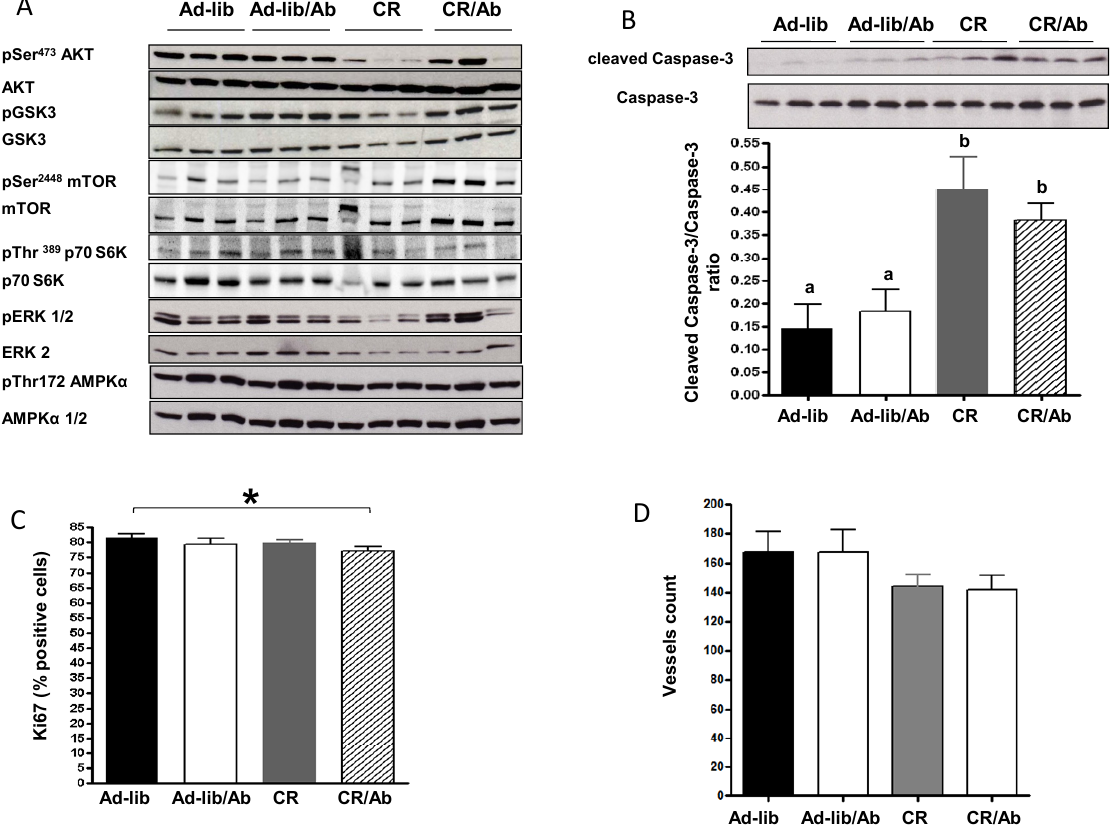
Figure 5. Effect of the different therapies on Akt pathway activation, apoptosis and proliferation. ( A ) Activation of the Akt pathway was assessed by western blotting on xenograft tissue lysate from 6 animals for each group. The Western blots are representative of one experiment ( n = 3 animals per group); ( B ) Apoptosis was measured by western blotting for cleaved Caspase-3 and toal caspase 3 on xenograft tissue lysate from 6 animals for each group. The Western blots are representative of one experiment ( n = 3 animals per